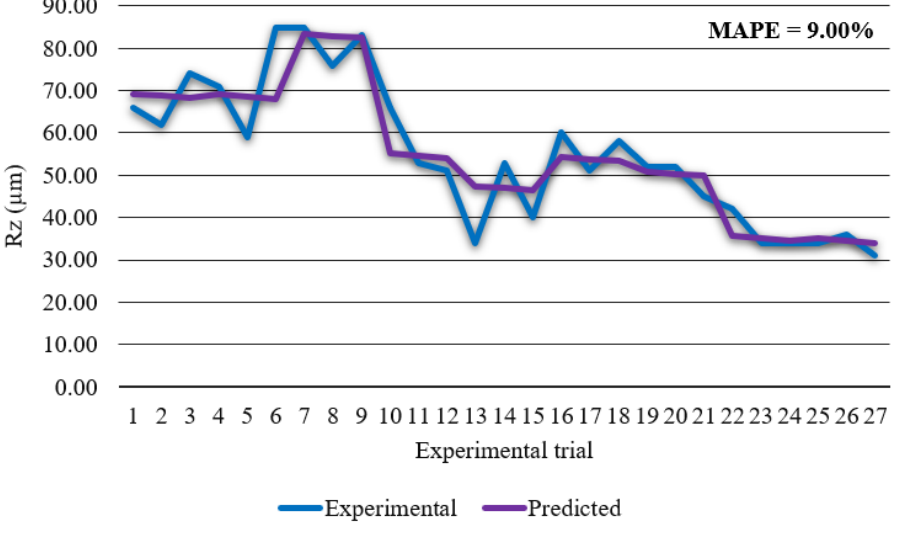
Figure 11 . Experimental surface roughness Rz vs. predicted surface roughness Rz . Table 9. ANOVA for surface roughness Rz.